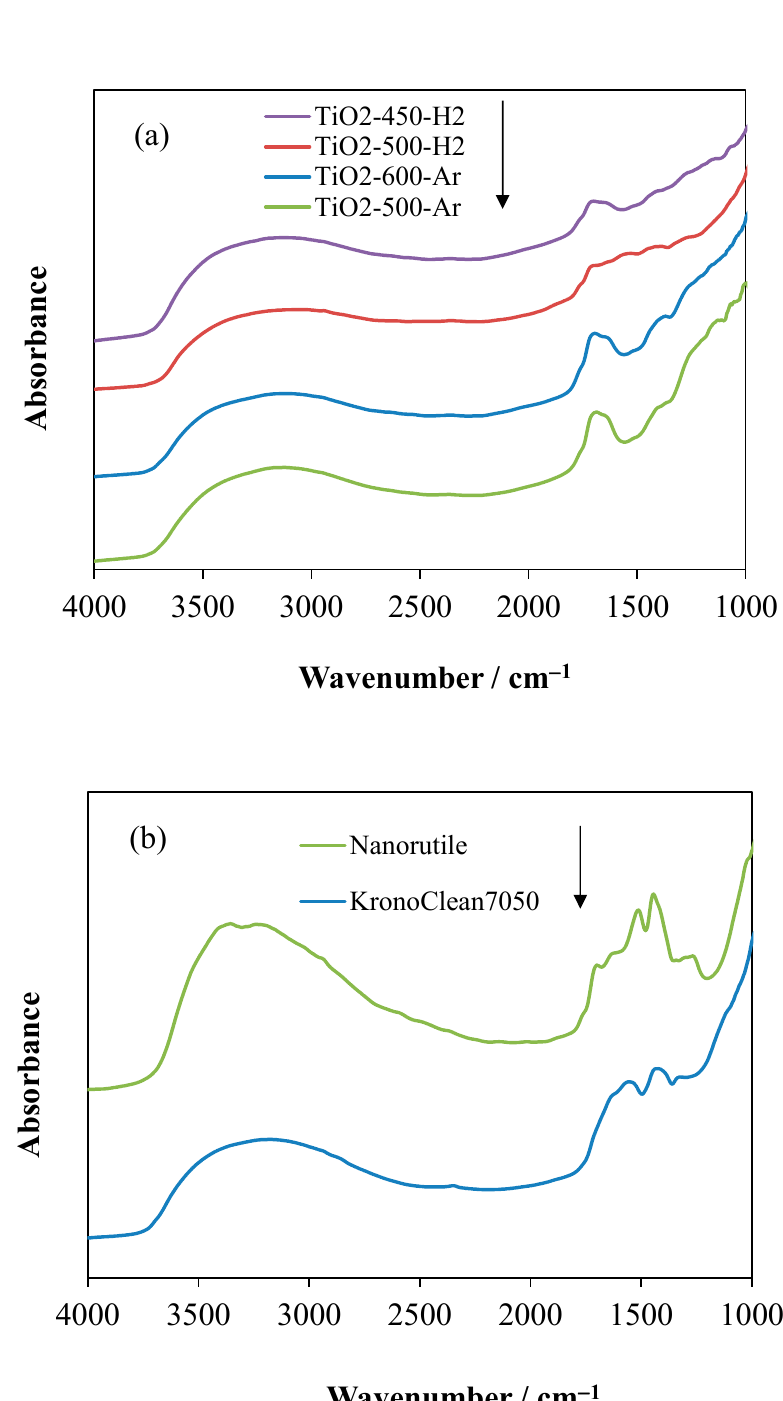
Figure 7. FTIR spectra of titania samples recorded after acetaldehyde adsorption: ( a ) prepared and ( b ) commercial.